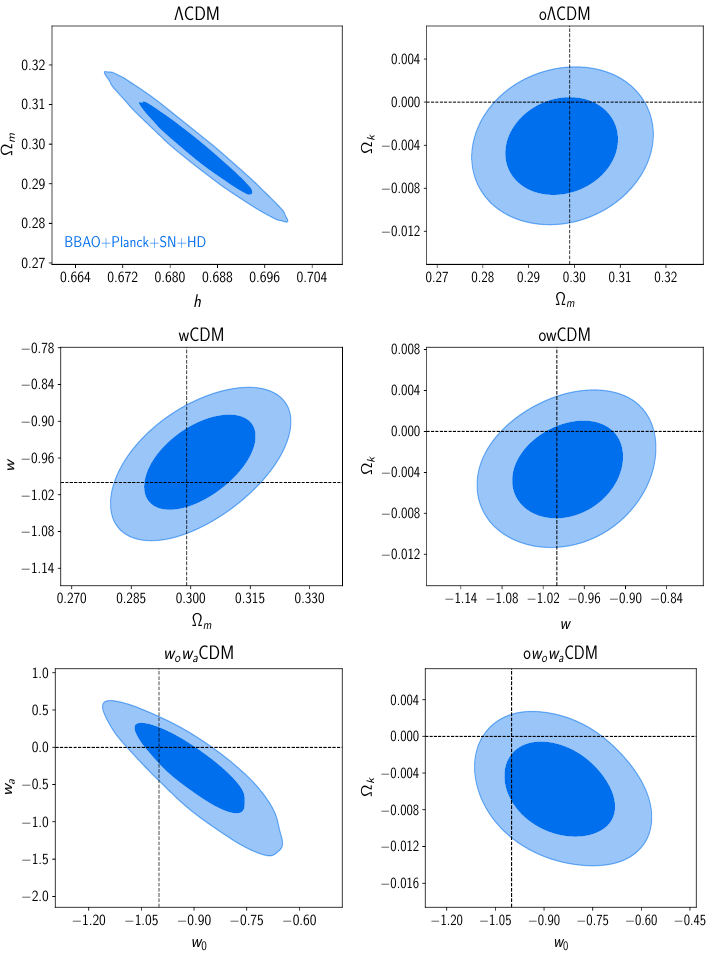
Figure 18. Two-dimensional posterior distributions with 1,2- σ confidence regions for different models. o Λ CDM refers to Λ CDM with curvature, ω CDM is a flat Universe with the dark energy equation of state as a free parameter, o ω CDM generalizes to non-zero curvature, w o w a CDM uses the CPL parameterization, and o w o w a CDM generalizes to non-zero curvature. The dashed lines show the standard Λ CDM